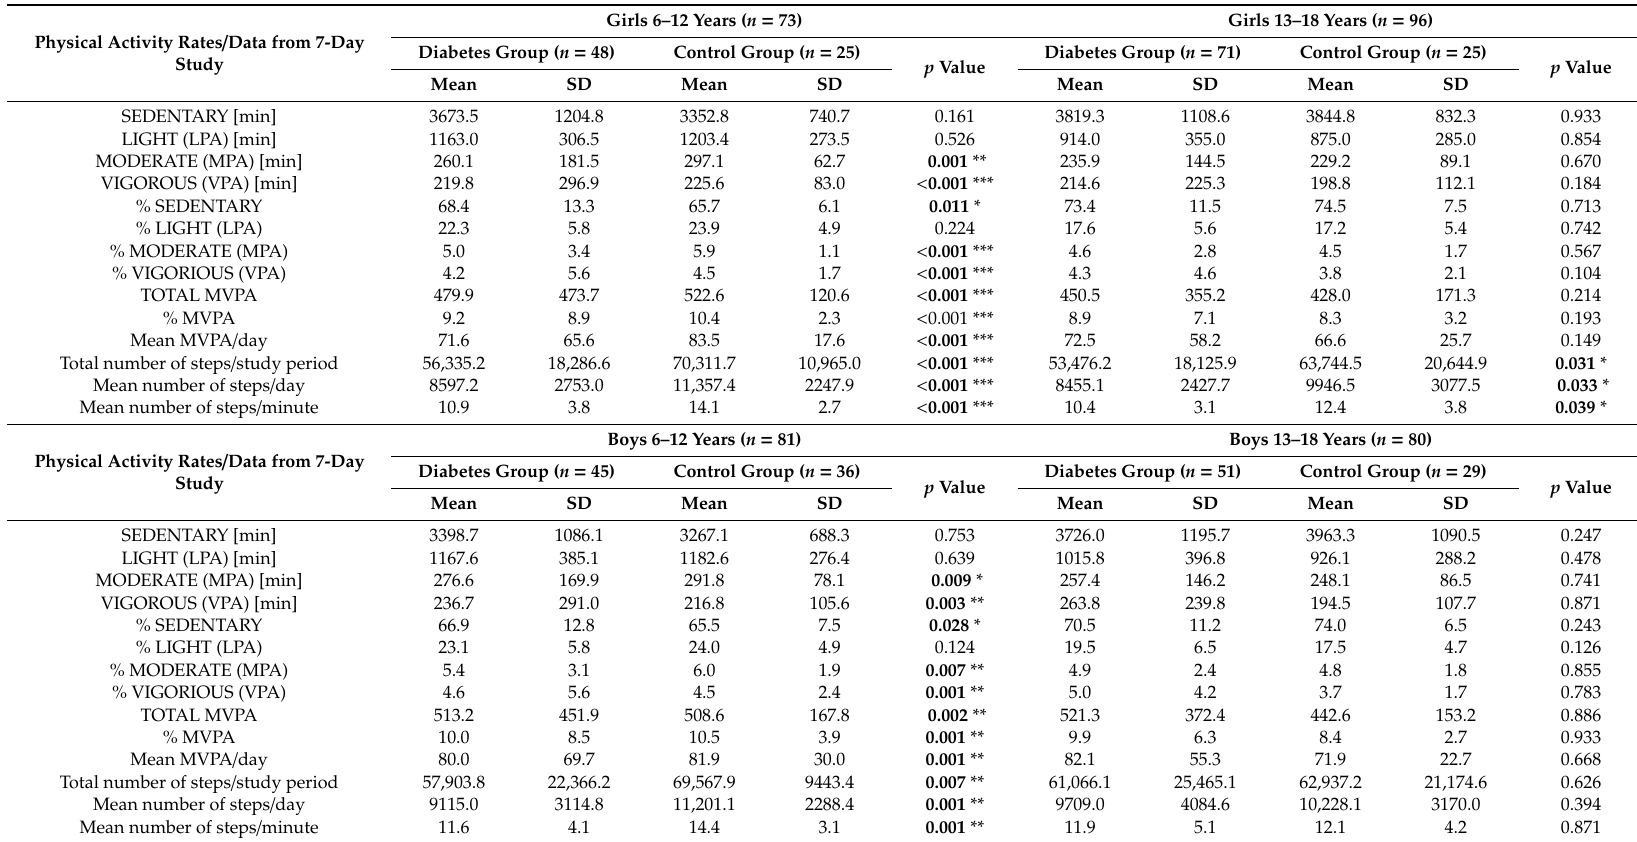
Table 8. Comparison of physical activity rates in the diabetes and the control groups depending on sex and